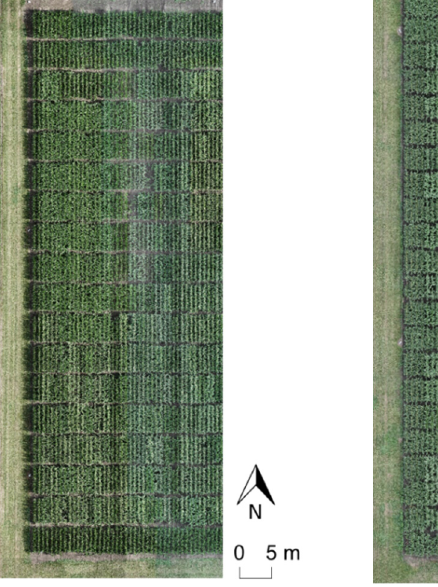
Figure 5. The ground mobile mapping system (PhenoRover) and onboard sensors used in this study.